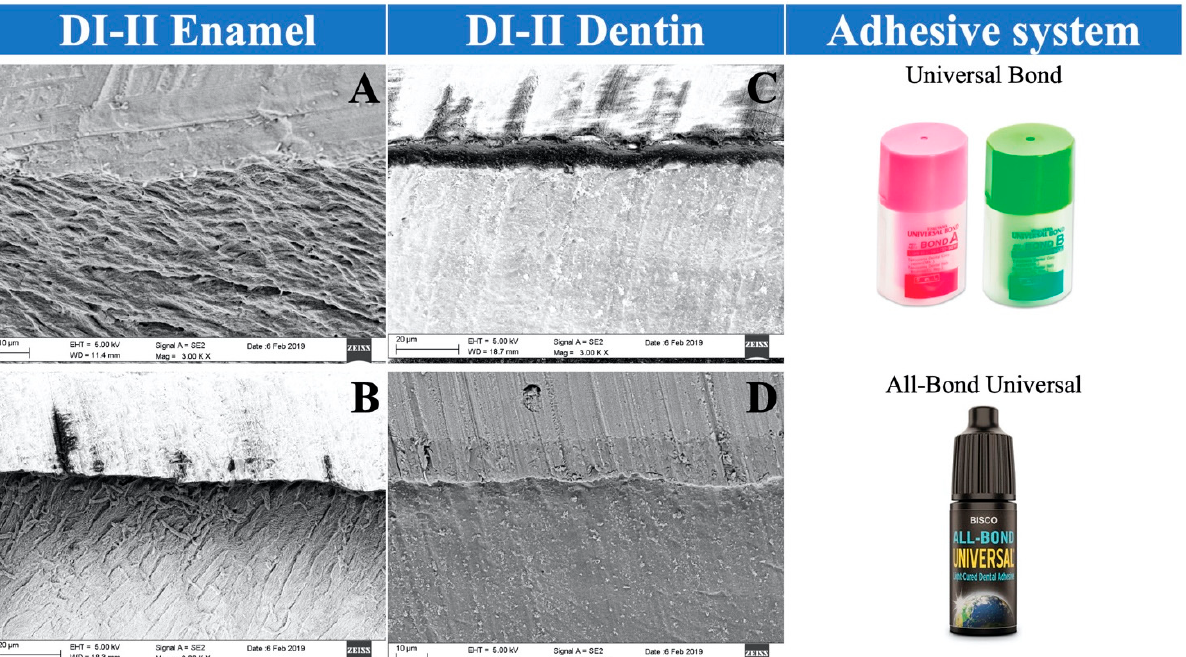
Figure 3. SEM images of interfacial bonding layer for universal adhesives on enamel ( A , B ) and dentin ( C , D ) affected by DI-II. Images ( A , B ): composite restoration ( upper part) and sound enamel ( lower part). Images ( C , D ): composite restoration ( upper part) and DI-II-affected dentin ( lower part).